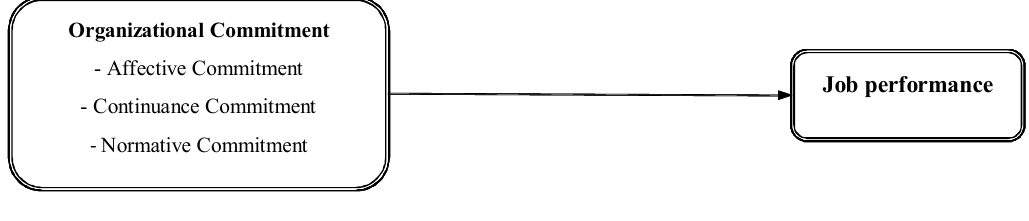
Fig. 1. Conceptual Model of